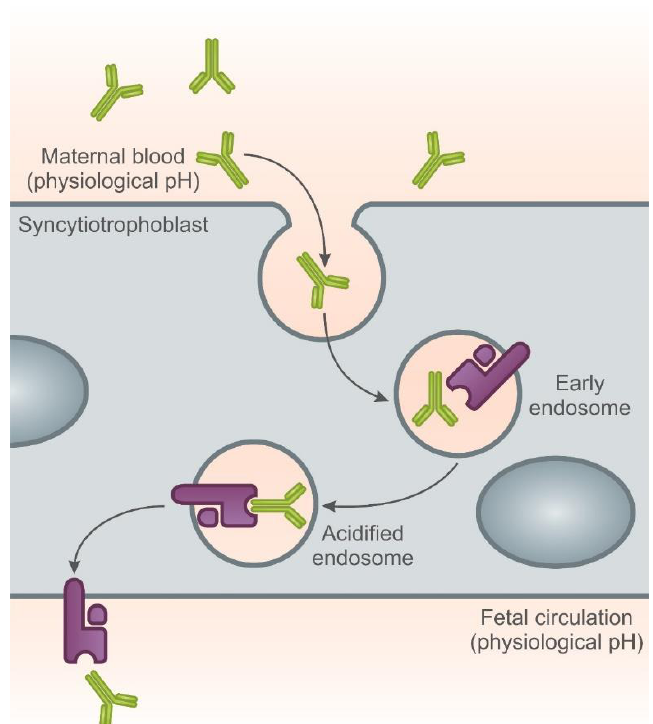
Figure 2. The neonatal Fc receptor (FnRn) mediates the perinatal transfer of IgG. In humans, the neonatal Fc receptor for IgG (FcRn) binds maternal IgG in an acidic environment, transcytoses is across a polarized epithelial-cell barrier and releases a physiological pH. In humans, maternal-fetal IgG transfer occurs across the syncytiotrophoblast of the placenta. FcRn is expressed in the internal vesicles of the syncytiotrophoblast. On acidification in the endosome, FcRn binds to maternal IgG and transcytoses it to the fetal circulation where it is released as physiological pH. IgG and FcRn molecules can also migrate back to the maternal placenta. Such